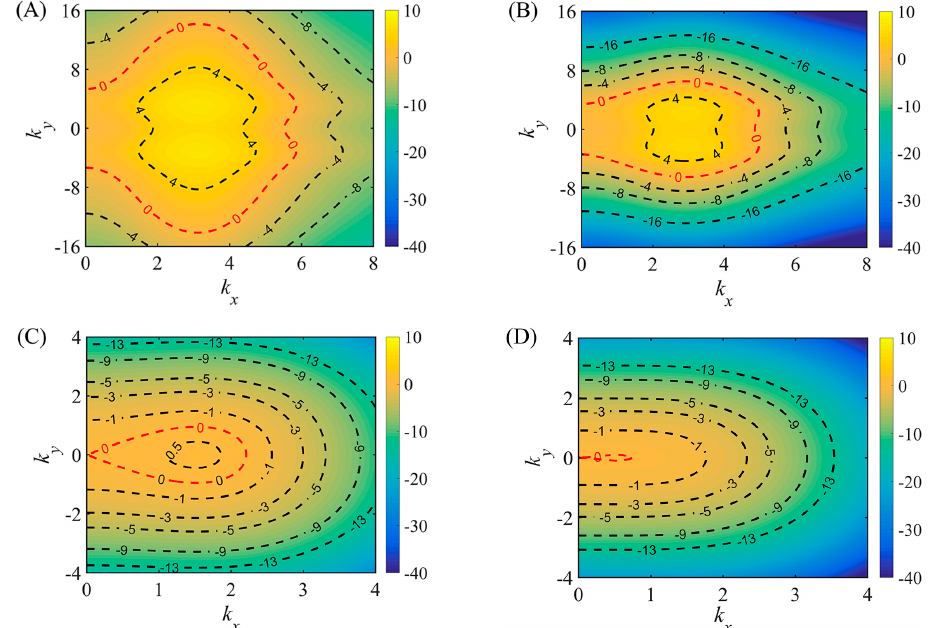
(cid:0) (cid:1) k x , k y for different values of D.